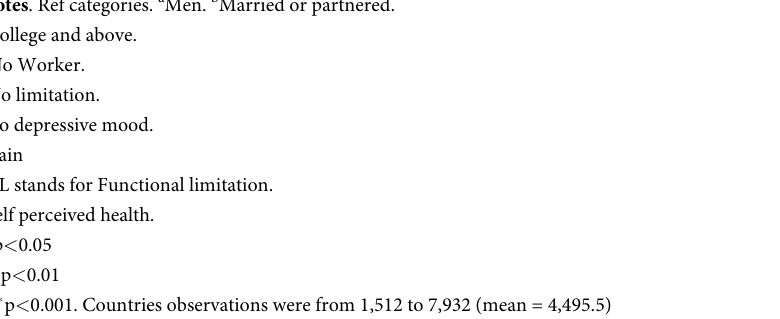
liness (OR = 1.39; 95% CI: 1.10–1.75). The relationship between country-level economic Model2 inequality and loneliness was independent of individual-level compositional factors and coun- try-standardised GDP (Model 4). GDP did not have a statistically significant relationship with loneliness and did not improve the model fit or explained variance; therefore, Model 3 was the best solution for explaining the prevalence of loneliness.